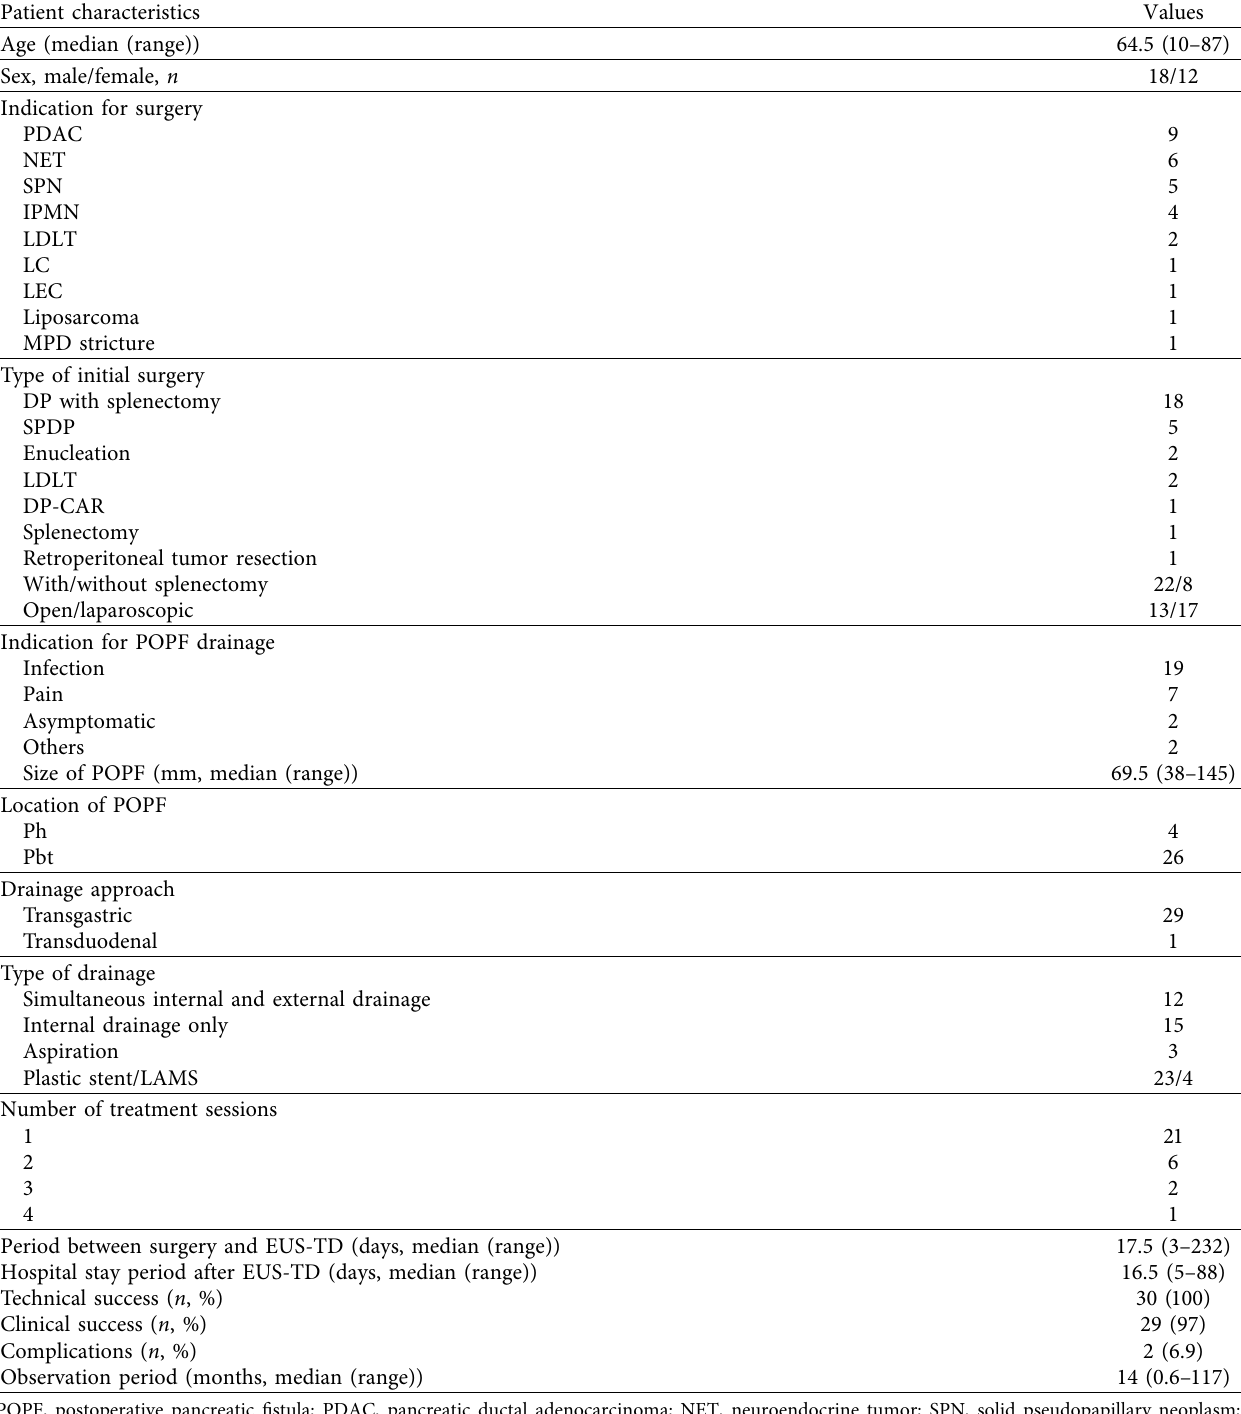
Table 1: Characteristics of enrolled